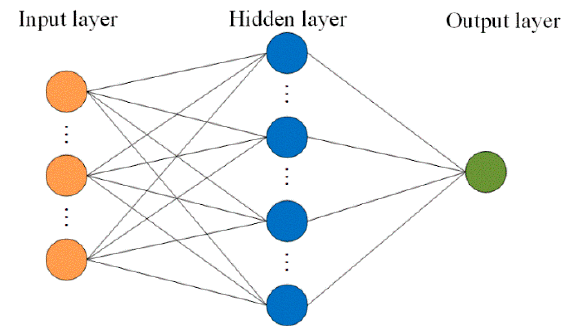
Figure 4. A basic BPANN model structure for modeling MRE isolator.